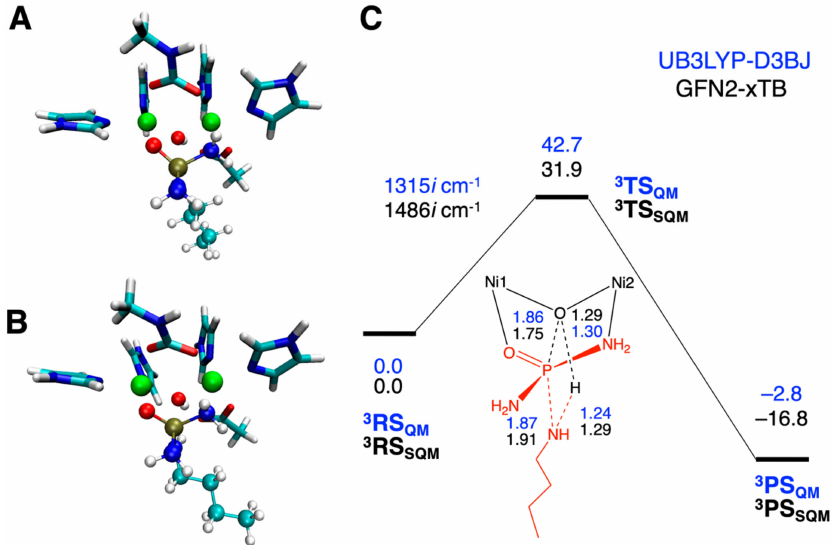
Figure 5. ( A ) NBPTO-bound complex optimized at the UB3LYP-D3BJ/def2-SVP level ( 3 RS QM ); ( B ) NBPTO-bound complex optimized at the GFN2-xTB level ( 3 RS SQM ); and ( C ) potential energy profiles (in kcal/mol) and illustration of the transition state structures with computed imaginary frequencies corresponding to the inhibition process for NBPTO obtained with the UB3LYP-D3BJ/def2- SVP and GFN2-xTB